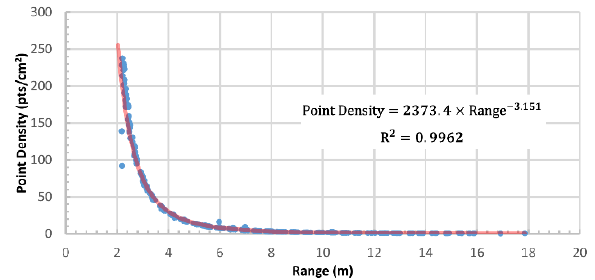
Figure 4. Correlation between range and point density at the sampling points on the stripe.